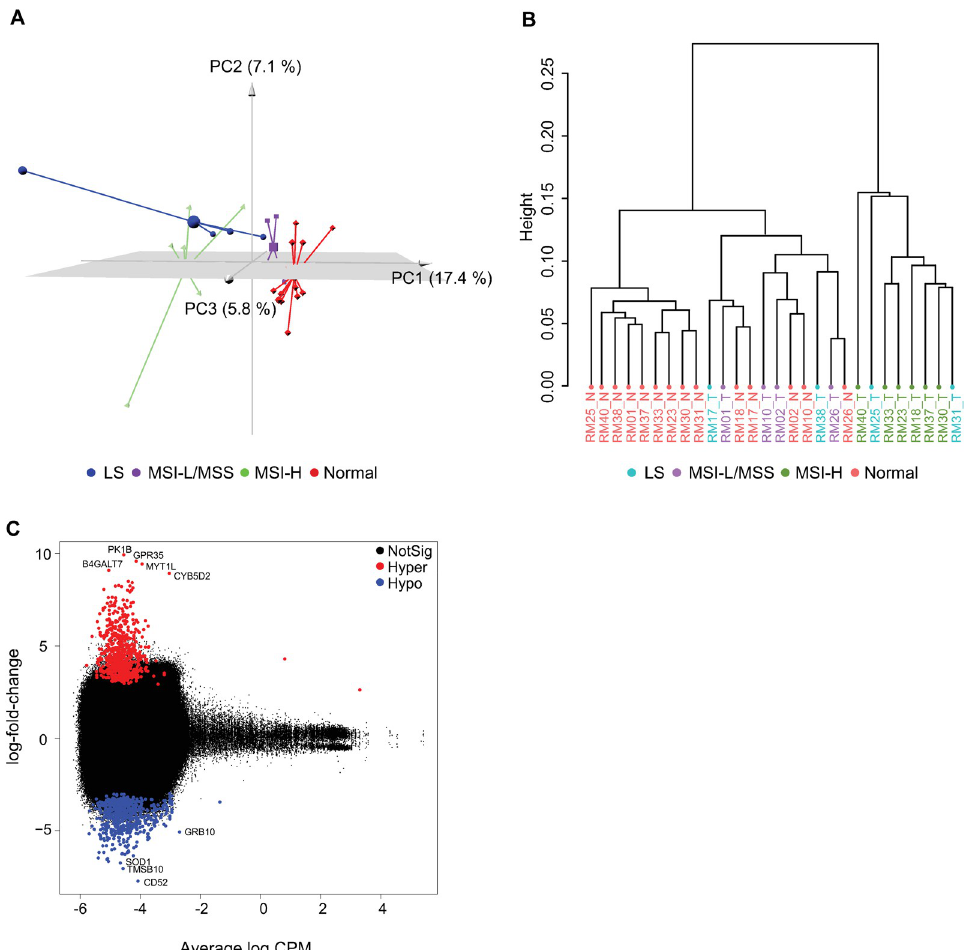
Fig 3. Methylation analysis of rhesus CRC. (A) 3D PCA of DNA methylation in rhesus specimens characterizing the trends exhibited by differentially methylated region profiles of sporadic MSI-H (green pyramid), sporadic MSS and MSI-L (purple cube), Lynch syndrome (blue sphere), and normal tissue (red diamond) samples. Each shape represents a tissue sample type. Each group clusters separately; however, sporadic MSS and MSI-L CRC samples are closer to normal tissue samples; (B) Hierarchical clustering of DNA methylation profiles assesses by CpG methylation using Pearson’s correlation. Distance displays the relationship between rhesus tumors and matched normal tissue samples with parameters set as distance method: “correlation”, clustering method: “ward”; (C) Significant differentially methylated regions (DMRs) of rhesus tumors displaying MSI-H and MSI-L/MSS phenotypes at FDR of 5%. PK1B , B4GALT7 , GPR35 , MYT1L and CYB5D2 are among hyper-methylated genes, and GRB10 , SOD1 , TMSB10 and CD52 are hypo- methylated.